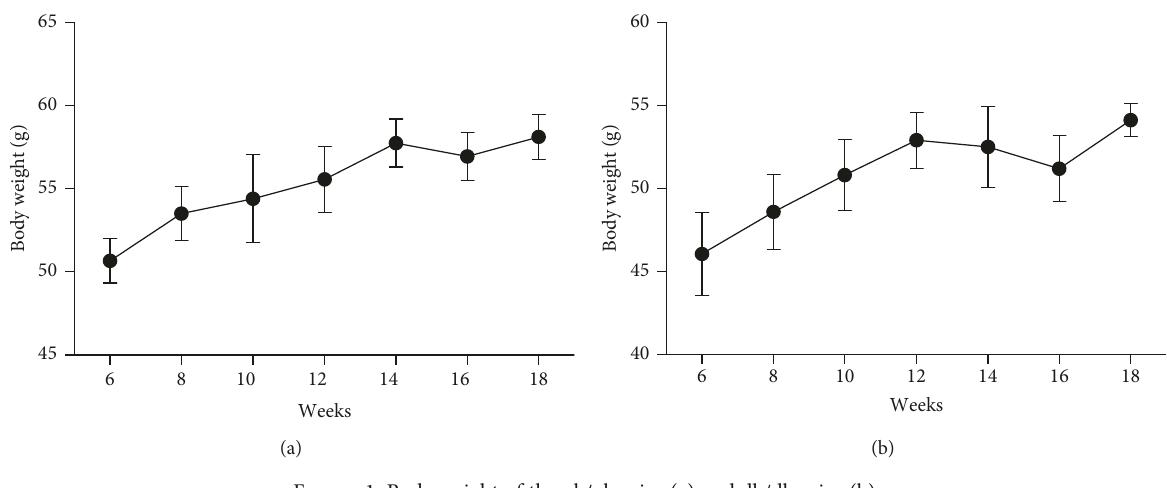
Figure 1: Body weight of the ob/ob mice (a) and db/db mice (b).